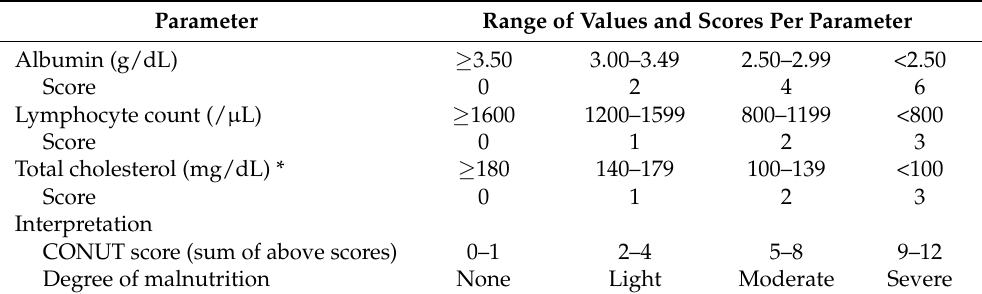
Table 1. Scoring and interpretation of the controlling nutritional status (CONUT) score. Parameter Range of Values and Scores Per Parameter Albumin